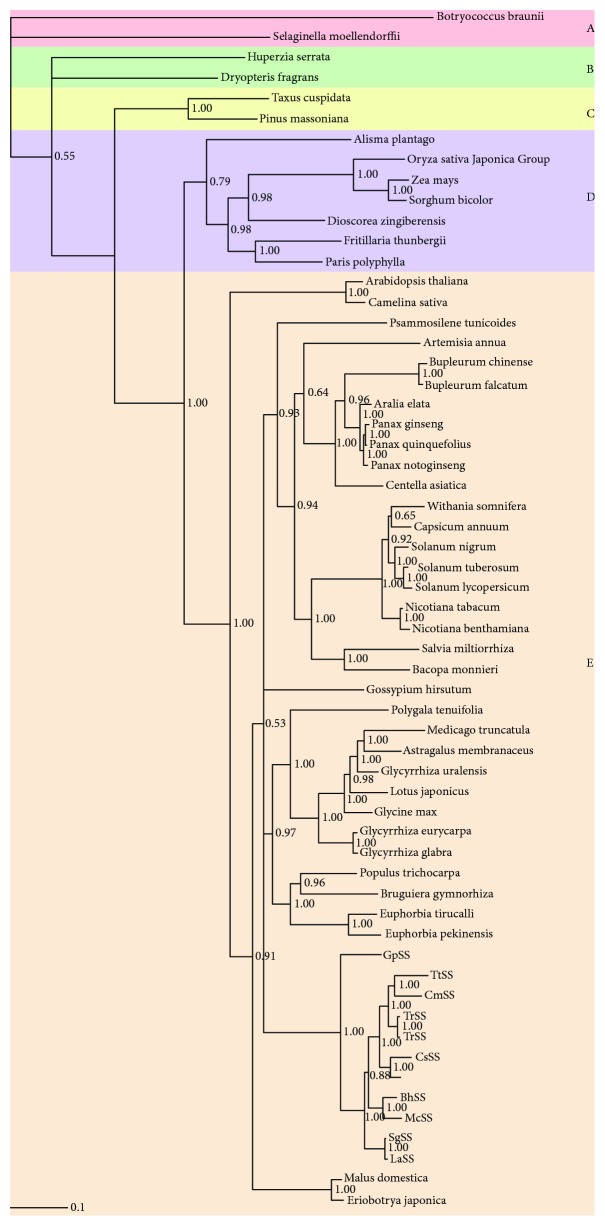
Phylogenic tree of terrestrial plant SQS was inferred by Bayesian analyses and divided into five clades. Botryococcus braunii and Selaginella moellendorffii were used as outgroup A. Pteridophyte, Gymnosperms, Monocotyledons, and Dicotyledons were labeled as groups B, C, D, and E, respectively. Posterior probabilities are labeled above branches. Numbers indicate the Bayesian probabilities for each phylogenetic clade. Abbreviations of GpSS, TtSS, CmSS, TrSS, TkSS, CsSS, BhSS, MchSS, McSS, SgSS, and LaSS represent the squalene synthase of Gynostemma pentaphyllum, Trichosanthes truncata, Cucurbita moschata, Trichosanthes rubriflos, Trichosanthes kirilowii, Cucumis sativus, Benincasa hispida var. chieh-qua, Momordica charantia, Momordica cochinchinensis, Siraitia grosvenorii, and Luffa acutangula, respectively.